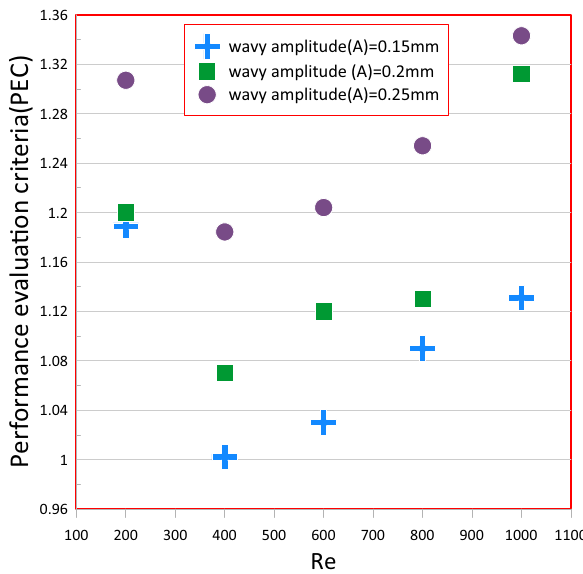
Figure 20. Variation of the thermallperformance factor versus Reynold number for wavy channel with various wavy amplitude (A) at distilled water as a